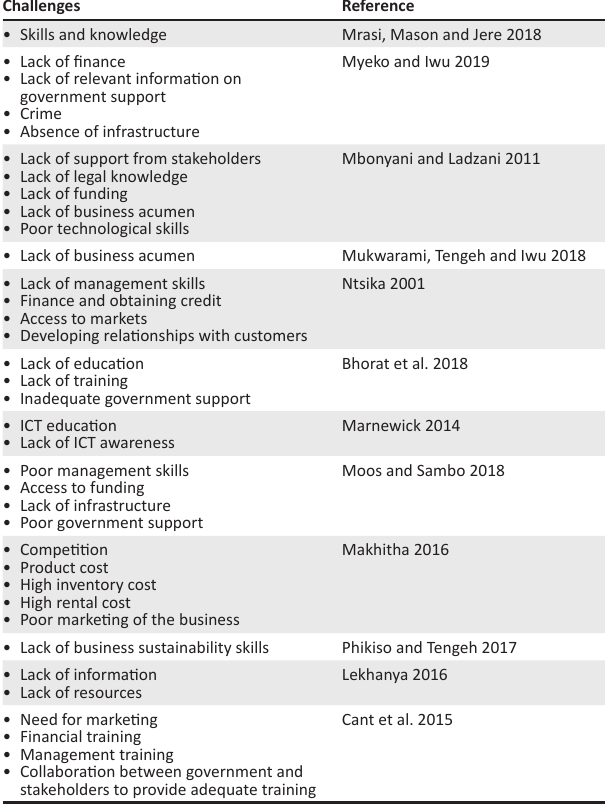
TABLE 1: Challenges faced by township small, medium and